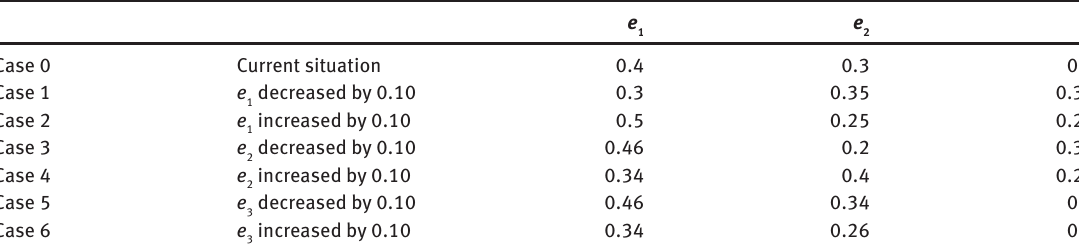
Table 14: Sensitivity Analysis for Experts’